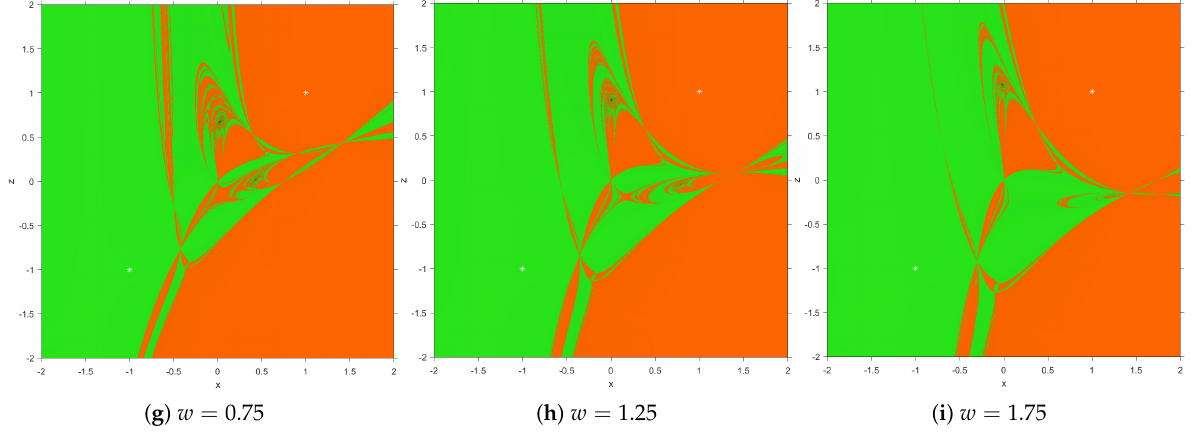
Figure 2. Dynamical planes of TM rational operator on p ( x ) , for m =